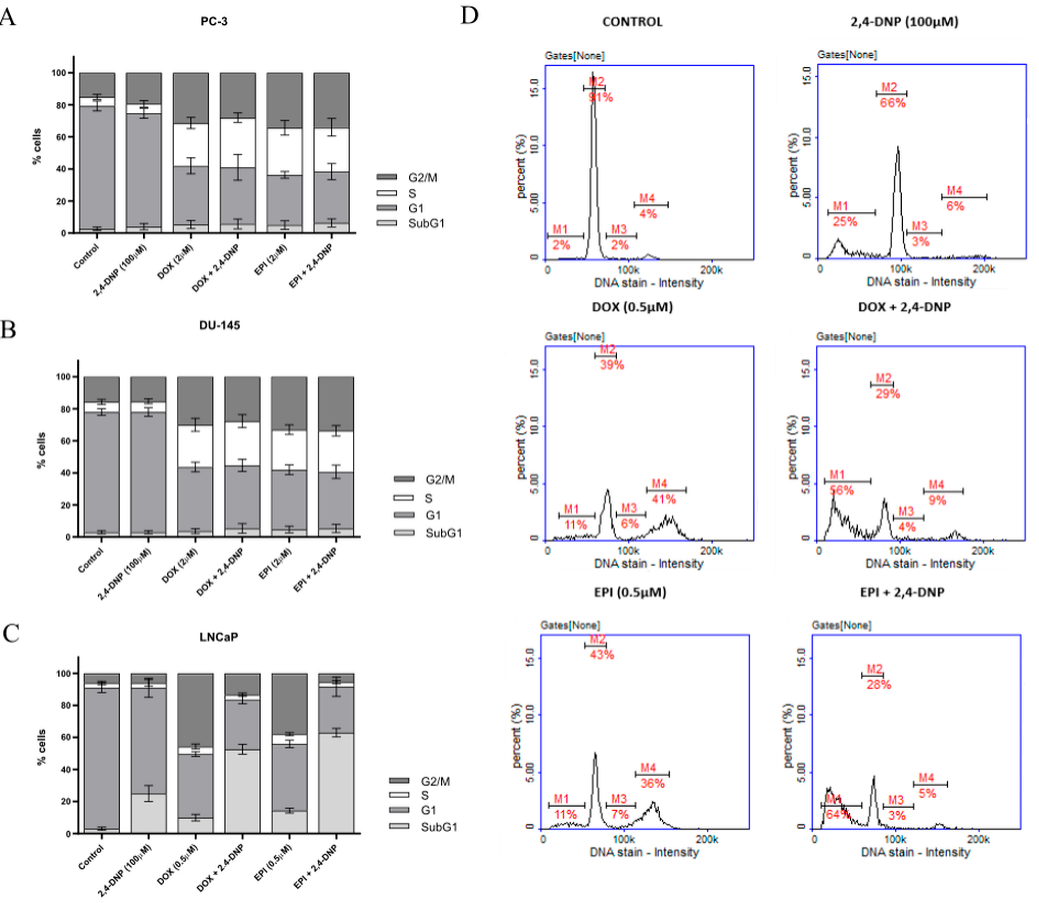
Figure 5. Analysis of cell cycle of ( A ) PC-3, ( B ) DU-145, ( C ) LNCaP cell lines. The cells were treated for 48 h with 2,4-DNP, DOX, and EPI or combined (2,4-DNP + EPI, 2,4-DNP + DOX). The values obtained from three independent experiments were presented as mean ± SD. ( D ) LNCaP cell cycle histograms representative of all repetitions of the experiment (M1—subG1, M2—G1, M3—S, M4— G2/M phase).